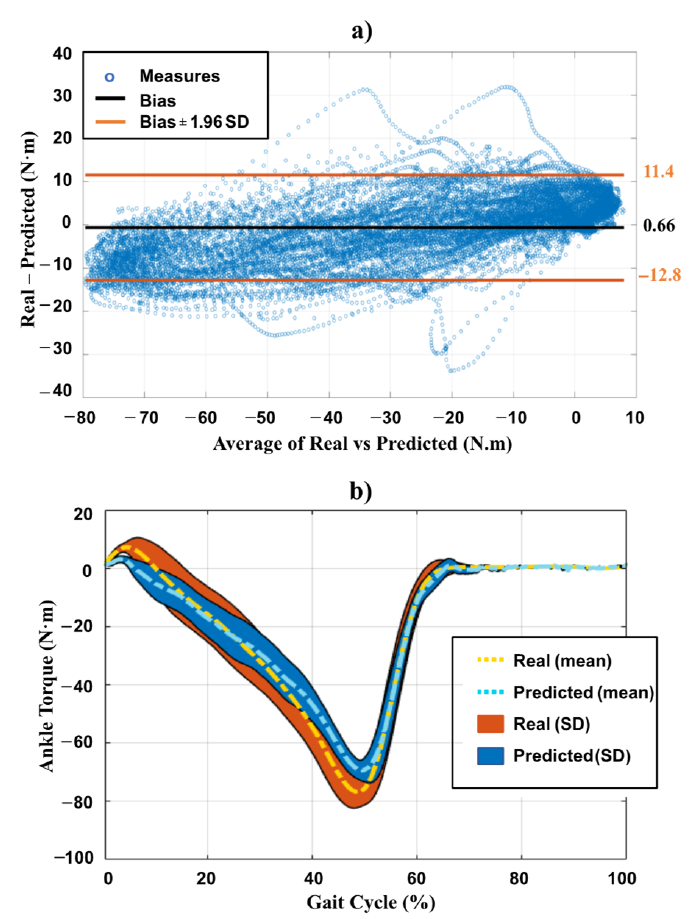
Figure 4. ( a ) Bland–Altman plot results; ( b ) Mean (dashed lines) and SD (filled area) of the real and CNN ‐ based predicted ankle joint torque for the test dataset.